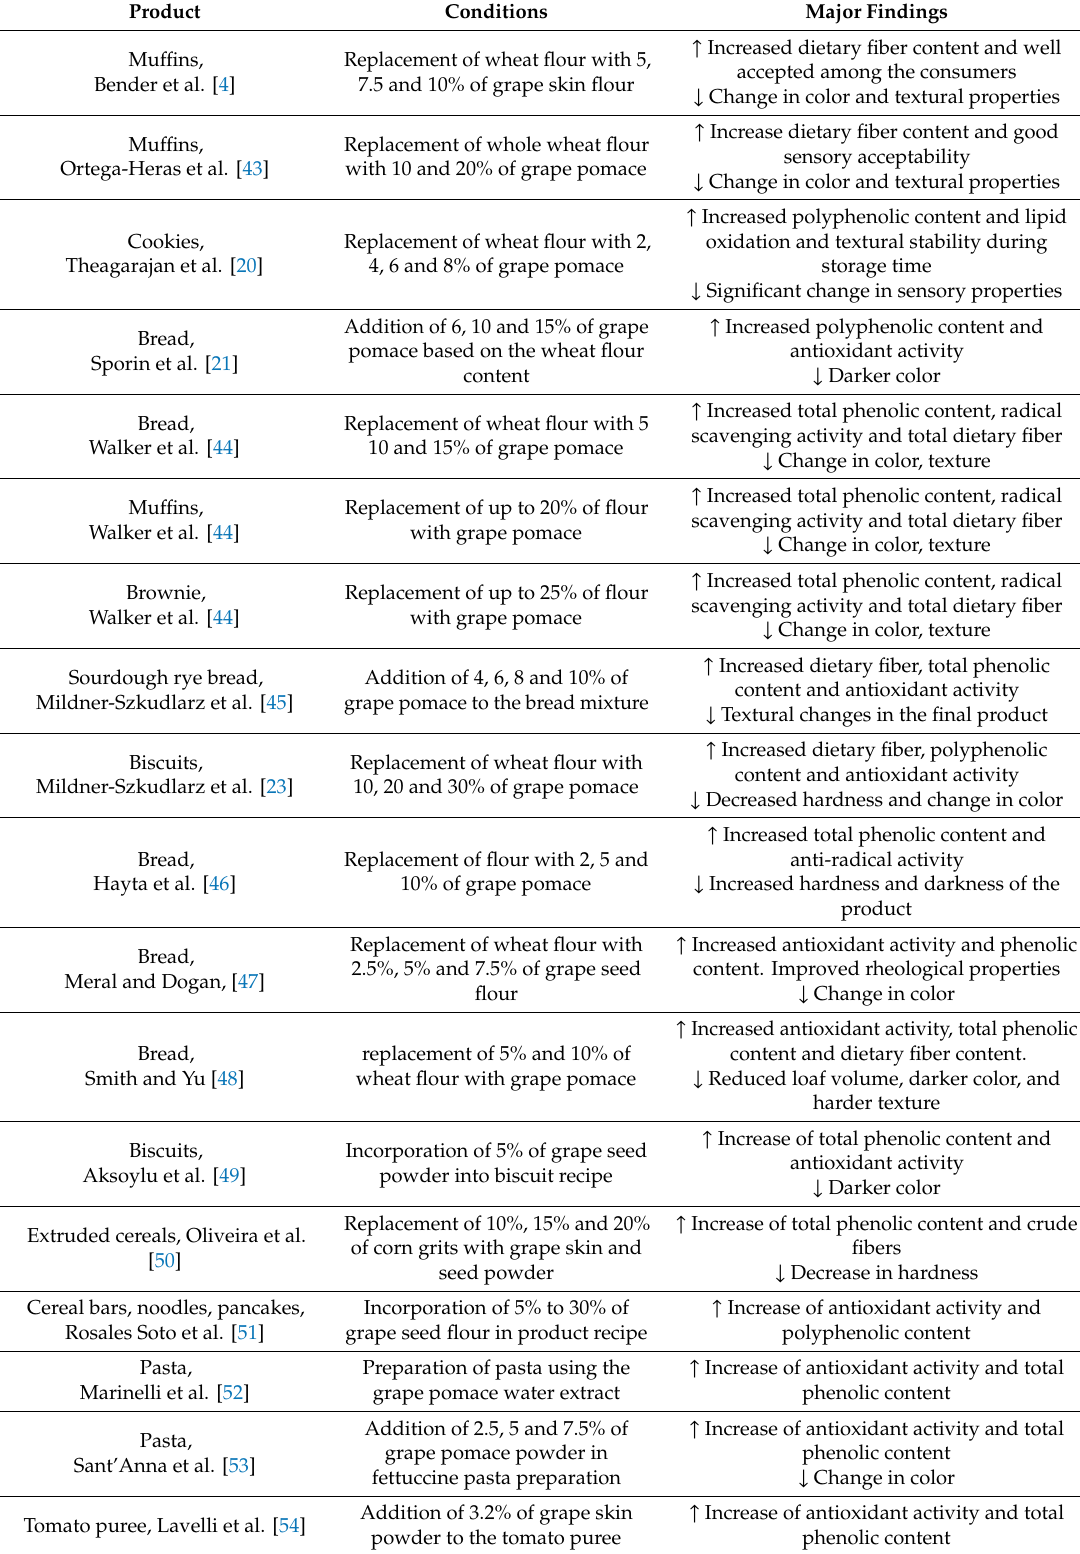
Table 2. E ff ect of addition of grape pomace to the plant origin